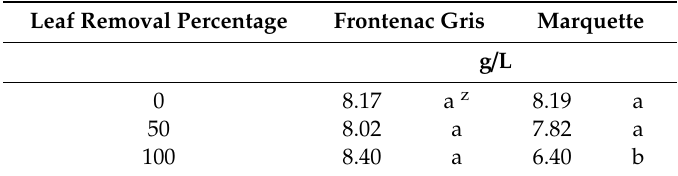
Table 9. E ff ect of fruit-zone leaf removal on titratable acidity at harvest for two V. riparia -based cultivars averaged over pruning levels, locations, and